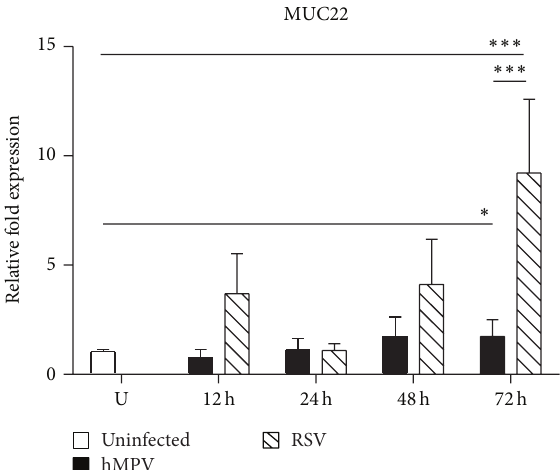
Figure 2: Cell-adhered mucins expression in A549 by hMPV and RSV infection. Cells were infected with hMPV or RSV at an MOI of 3 for 12, 24, 48, or 72 h. RNA was isolated, and the expression of MUC genes was determined by qRT-PCR. Data shown in the graphs are the mean of 5 independent experiments. Statistical significant differences are indicated. ∗ 𝑃 < 0.05 ; ∗∗ 𝑃 < 0.01 ; ∗∗∗ 𝑃 < 0.001 .